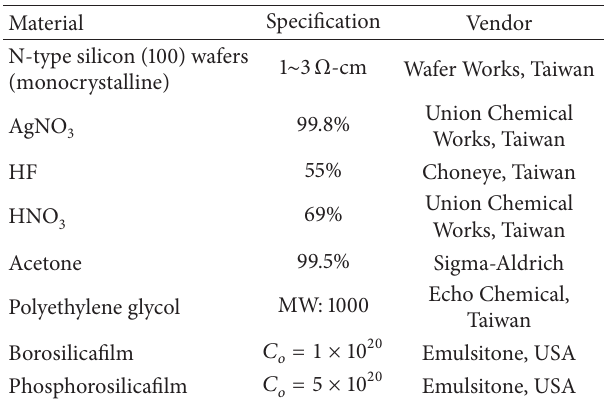
Table 1: Materials, specifications, and